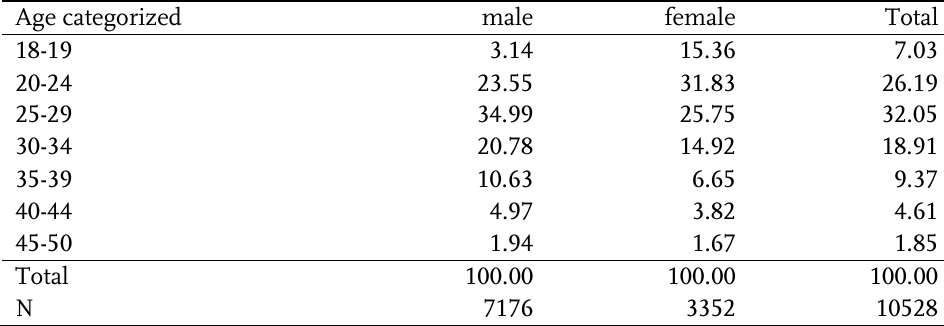
Table 1 : Age by gender (%) Age categorized